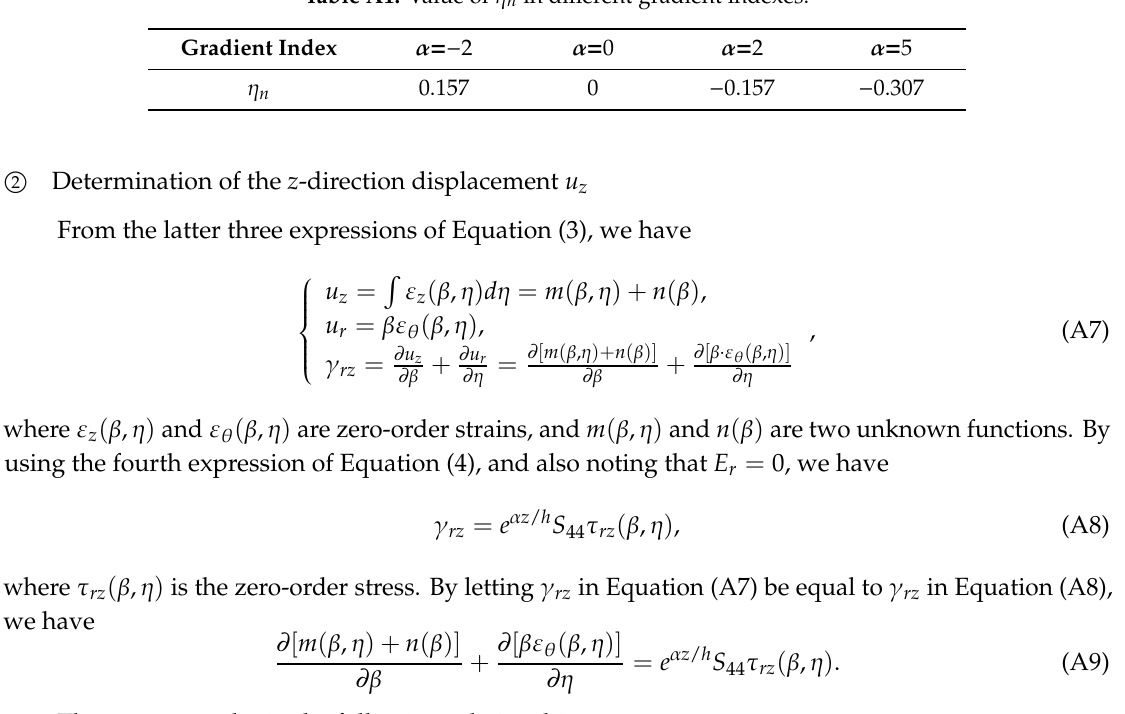
Table A1. Value of η n in di ff erent gradient